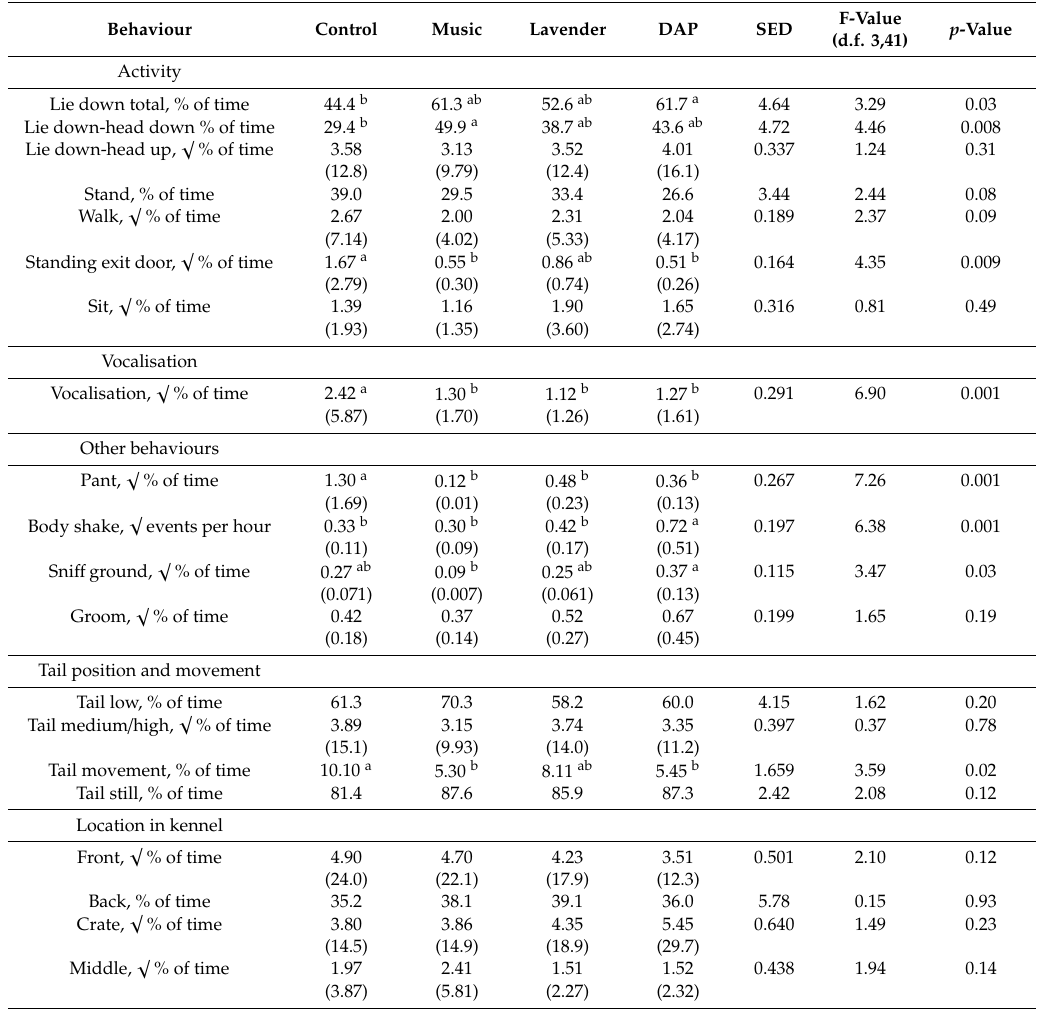
Table A2. The behaviour of shelter dogs ( n = 60) exposed to olfactory and auditory stimuli or a control treatment for 3 h / d on 5 consecutive days [65]. For square root ( transformed values are also reported in parentheses. Means that do not share a superscript letter are significantly di ff erent ( p < 0.05) by Tukey’s